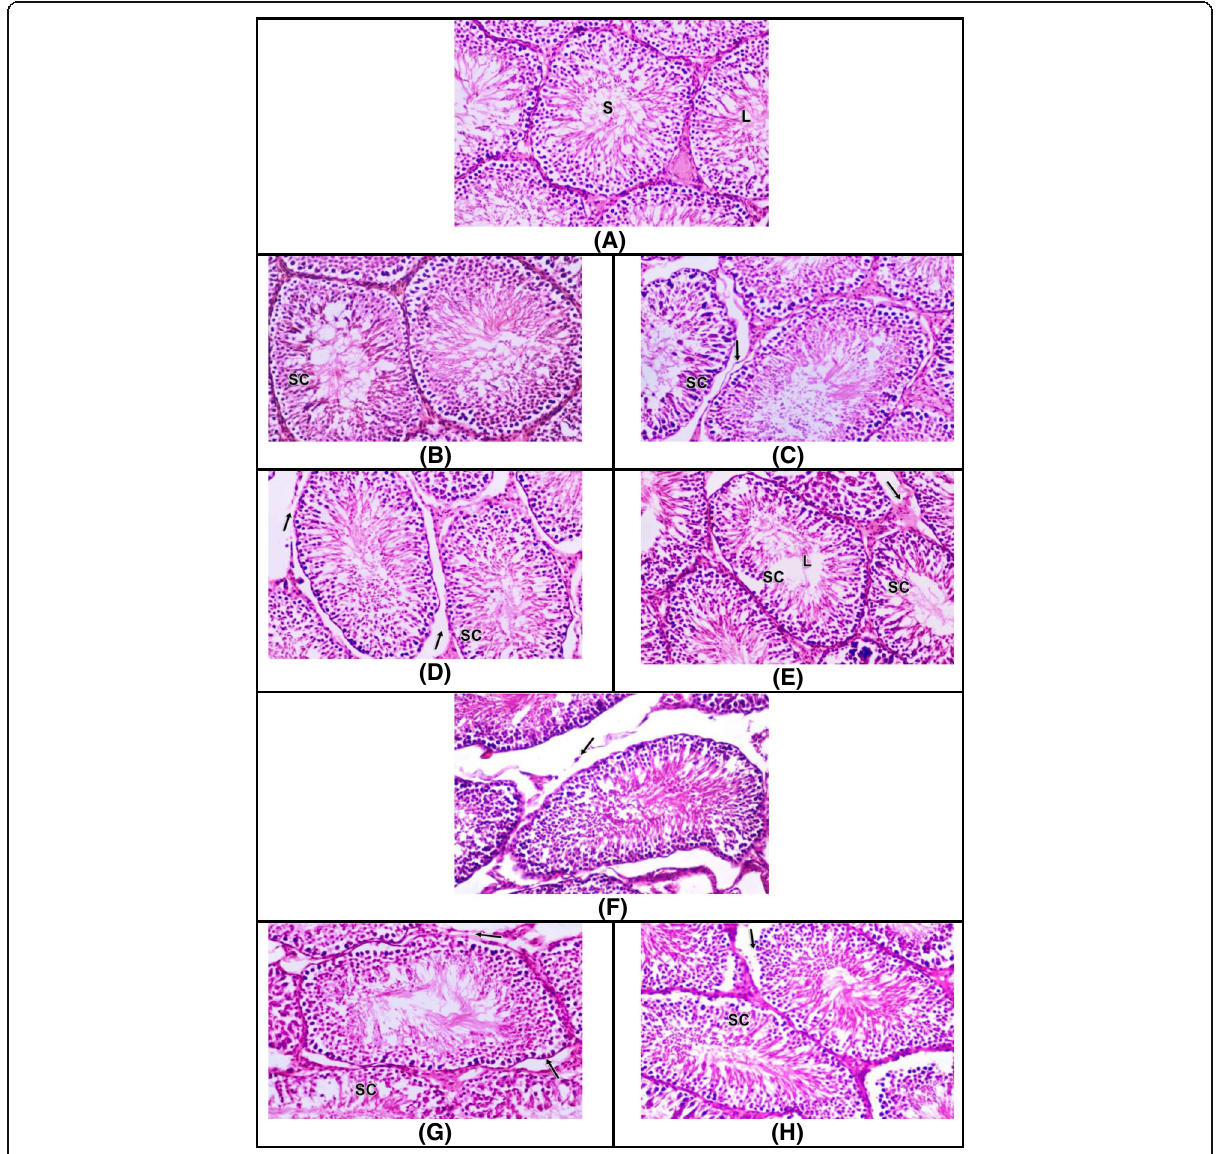
Fig. 1 a Photomicrograph of control testis showing normal histological structure of the seminiferous tubules with complete spermatogenic series (S) and small lumen (L) densely filled up with sperms (H&E × 200). b Photomicrograph of testis of the first treated group showing less dense packing of spermatogenic cell (SC) (H&E × 200). c , d Photomicrographs of testis of the second and third treated groups showing splitting of basement membrane (arrow) and less dense packing of spermatogenic cell (SC) in some seminiferous tubules (H&E × 200). e Photomicrograph of testis of the fourth treated group showing splitting of basement membrane (arrow) and less dense packing of spermatogenic cell (SC) with wide emptied lumen (L) (H&E × 200). f Photomicrograph of testis of the fifth treated group showing splitting of basement membrane of seminiferous tubules (arrow) (H&E × 200). g , h Photomicrographs of testis of the sixth and seventh treated groups showing splitting of basement membrane (arrow) and less dense packing of spermatogenic cell (SC) in some seminiferous tubules (H&E ×